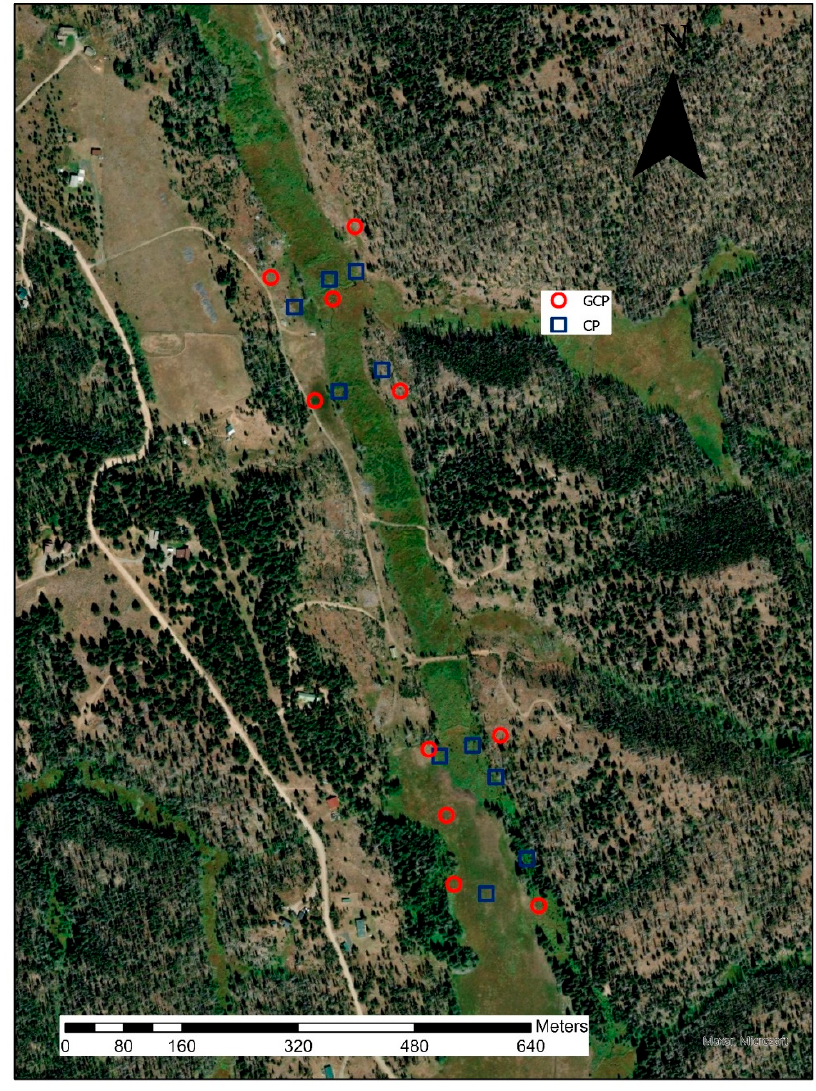
Figure A2. GCPs and CPs locations for treatment reach and control reach.